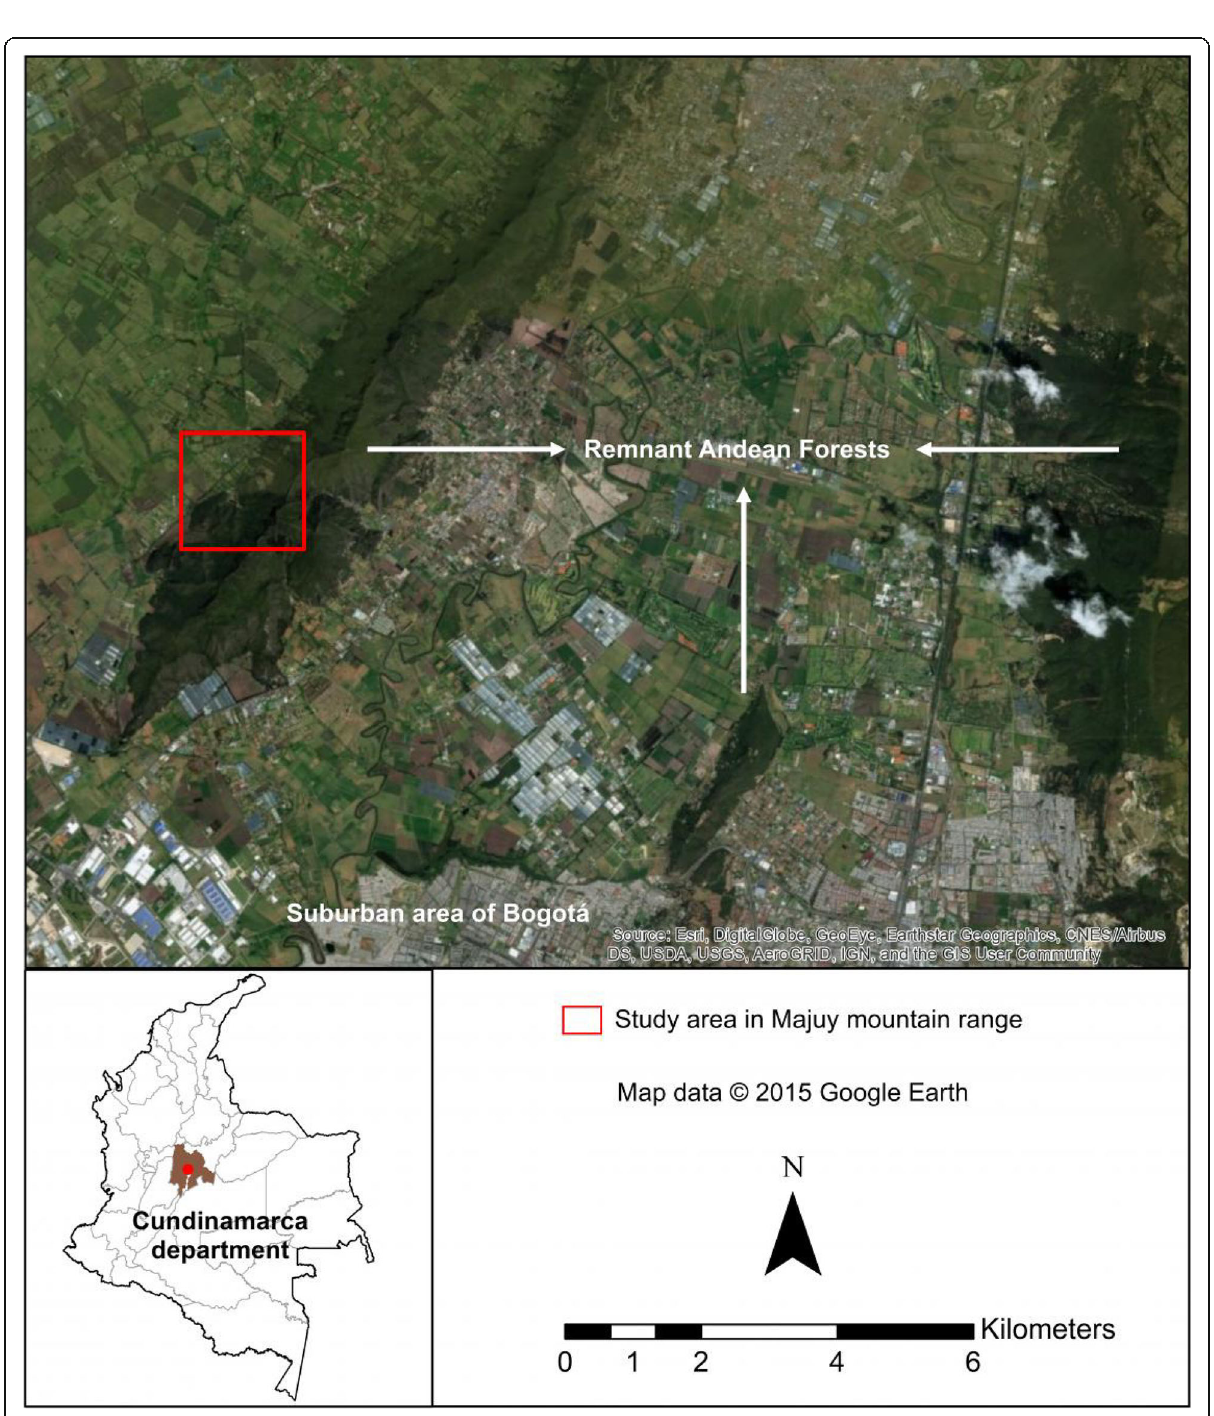
Fig. 1 Study area to the northwest of Bogotá in Tenjo, Cundinamarca. Study area (red rectangle) covering part of the hills and low mountains within the Bogotá High plain. Dark green areas correspond to native vegetation remnants, mostly forests; light green and orange to pastures and crops; and beige to urban centers (Map data © 2015 Google